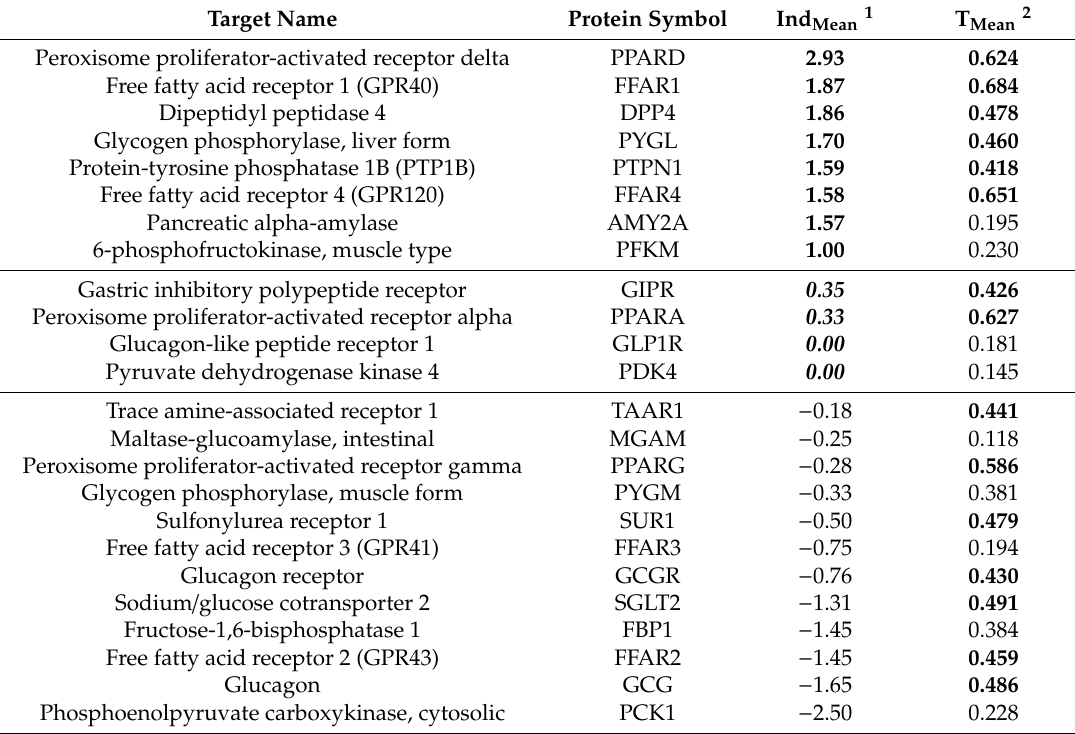
Table 2. In silico-predicted relevance of biotargets and corresponding hypoglycemic activity of bornyl derivatives 1